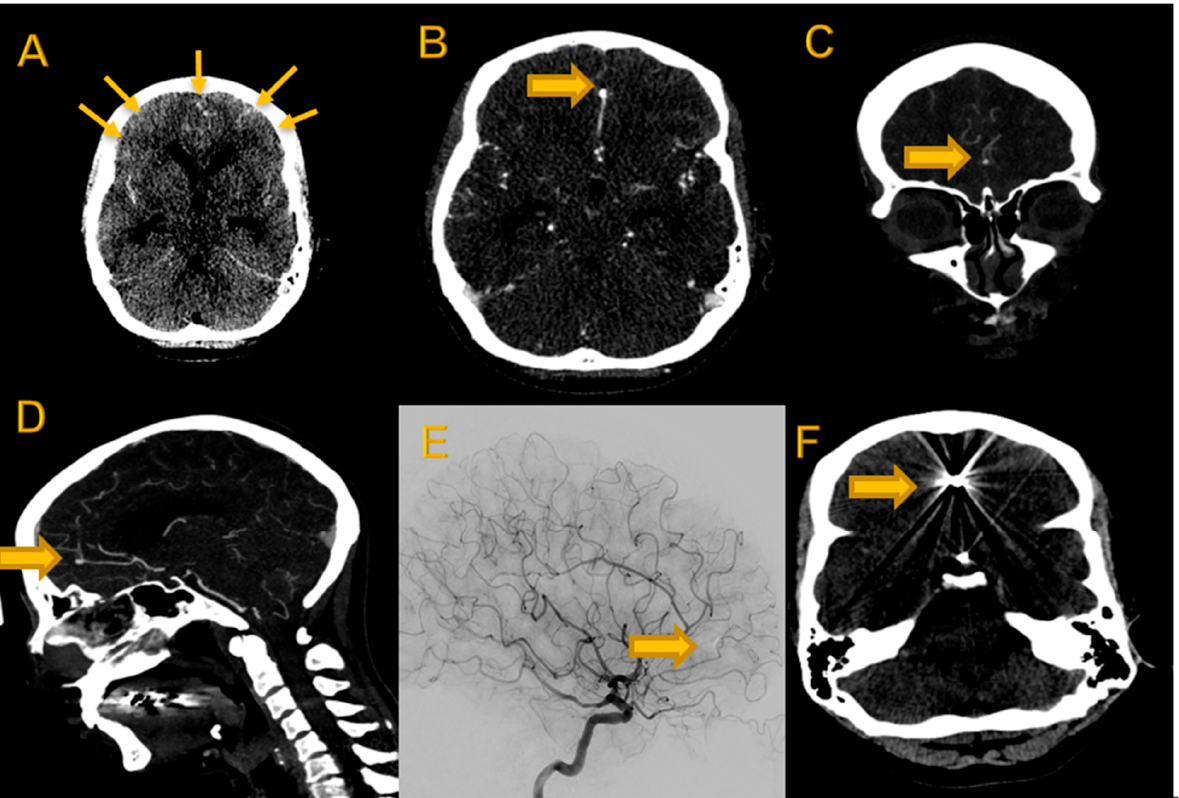
Figure 1. Imaging dataset of 42-year-old female patient with acute intracranial hemorrhage due to ACA aneurysm. ( A ) Non-contrast-enhanced axial cCT showing SAH [arrows]. ( B ) Contrast-enhanced axial slice with ACA aneurysm [block arrow]; ( C ) coronal reconstruction MIP with ACA aneurysm (block arrow); ( D ) sagittal reconstruction MIP with ACA aneurysm (block arrow) and ( E ) DSA after clipping (block arrow). ( F ) Postinterventional non-enhanced cCT with clip (block arrow).